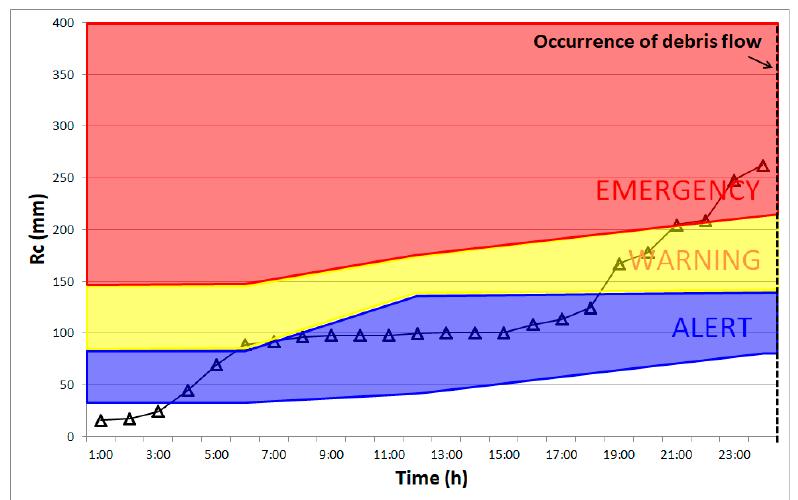
Figure 18. Debris flow forecasting using nomogram (Case 2).